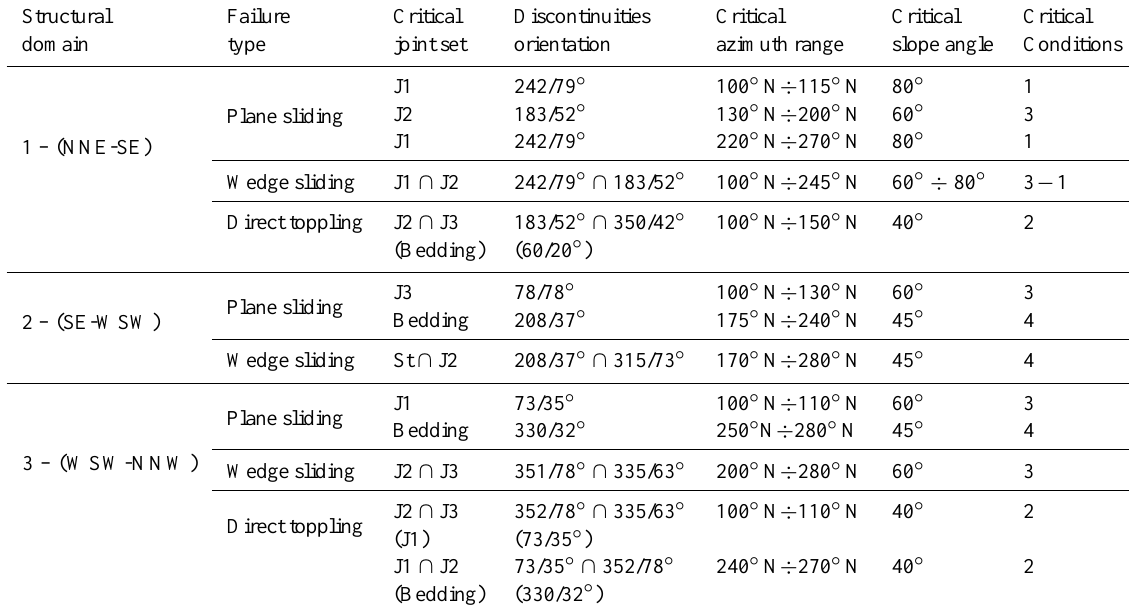
Table 2. Results of the stability analyses of the identified structural domains. Numbers in the column “Critical Conditions” indicate: (1) discontinuity daylighting; (2) basal discontinuity daylighting; (3) shear strength of rock joints; and (4) shear strength of marly/mudstone